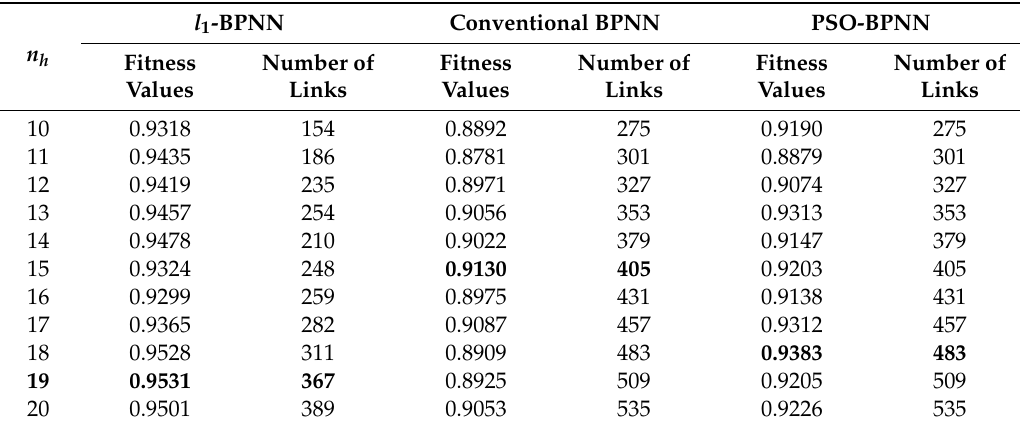
Table 2. Comparison of Fitness Values for Predicting the S 11